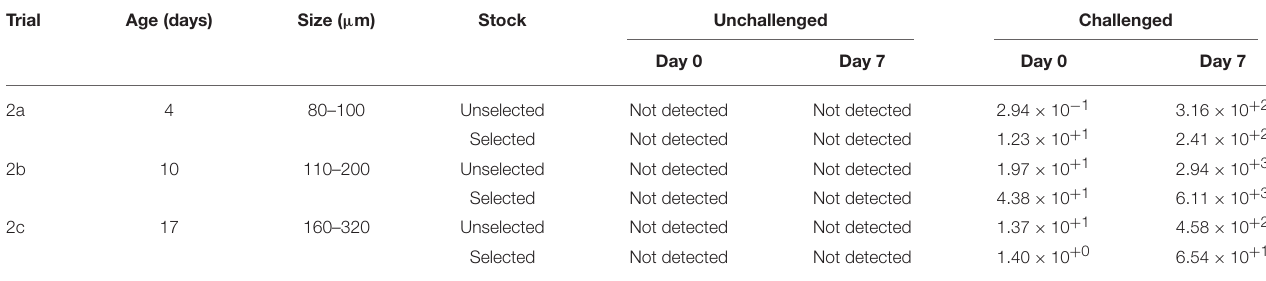
TABLE 5 | Quantification of OsHV-1 DNA in seawater (copies per µ L) for the unchallenged and challenged conditions in trial 2a, trial 2b, and trial 2c.